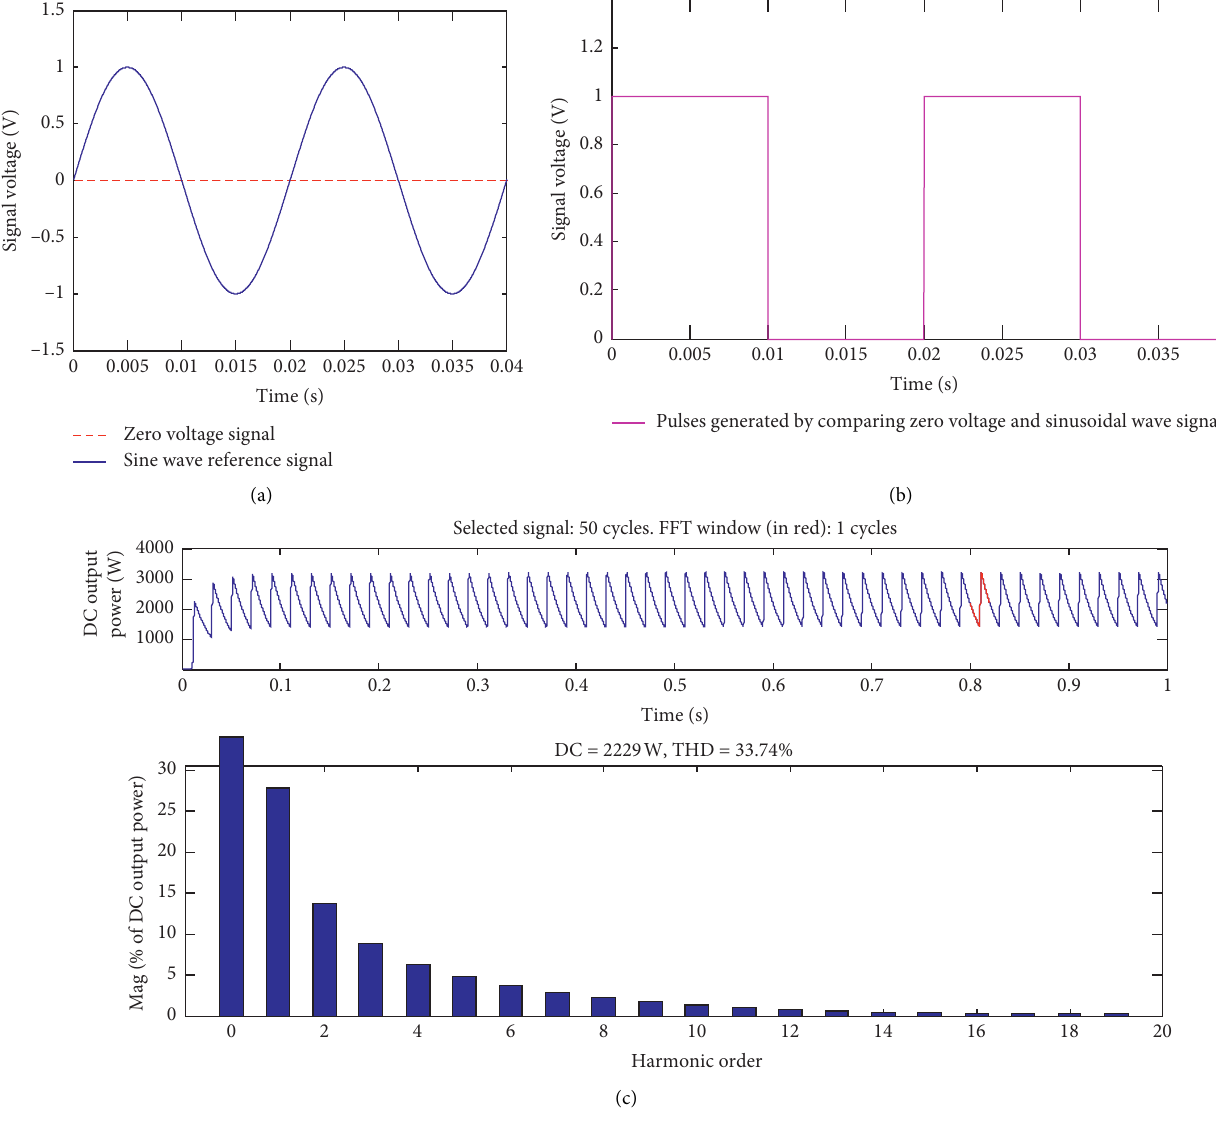
Figure 5: (a) ZPCSMS. (b) Firing pulses of ZPCSMS. (c) Spectral analysis of the output power of boost DC-DC converter using